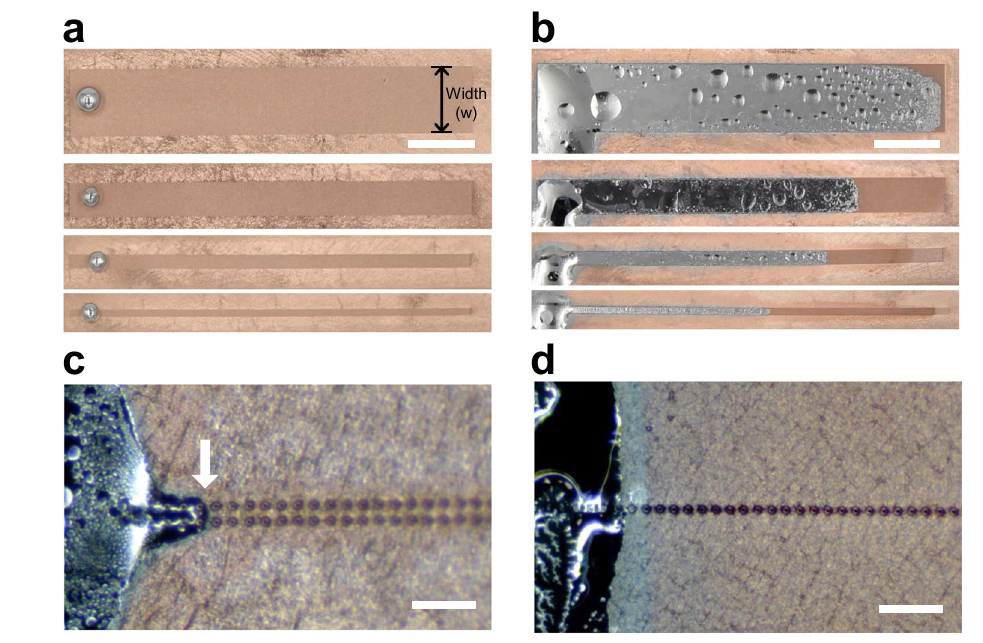
Fig. 3 | Effect of the width of rows of posts of Cu/PDMS on the imbibition of EGaIn. a EGaIn droplets sitting on the post-patterned Cu/PDMS with different widths of the patterns ( w ) in air (before exposure to HCl vapor). From the top, the numbers of the rows of posts are 101 ( w =5025 μ m), 51 ( w =2525 μ m), 21 ( w =1025 μ m),and11( w =525 μ m). b DirectionalwettingofEGaInin( a )10minafter